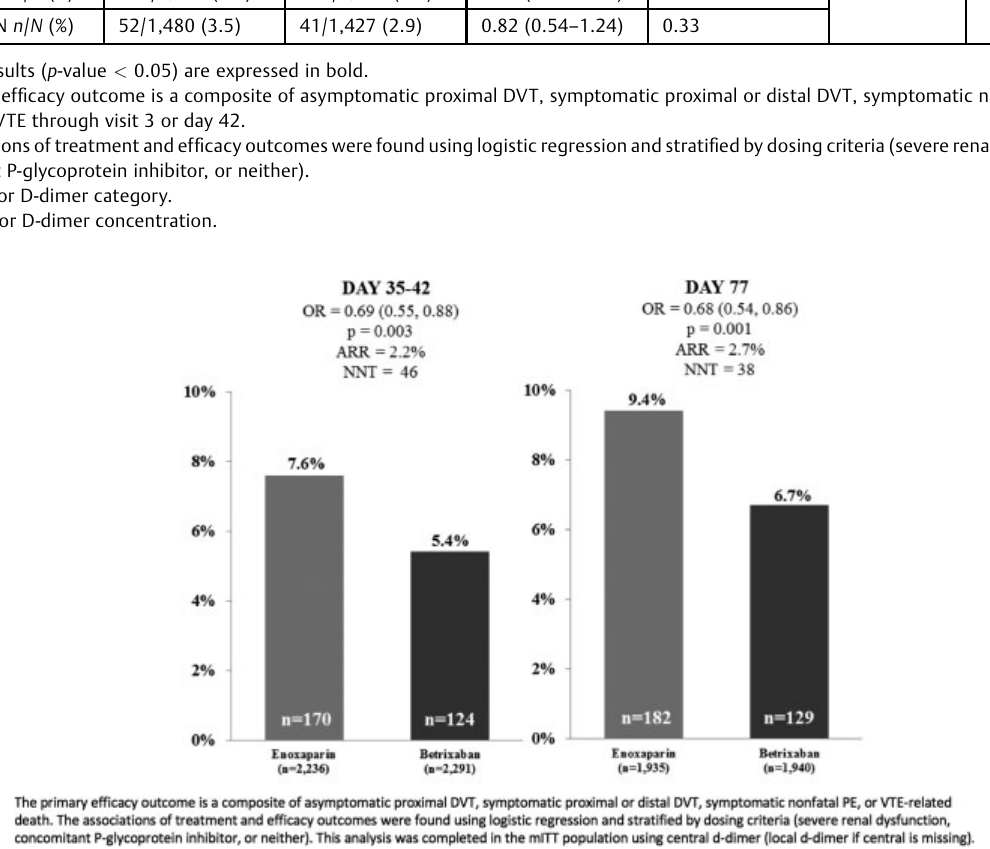
Fig. 1 Primary ef fi cacy outcome for D-dimer-positive patients through visit 3 and end of study.